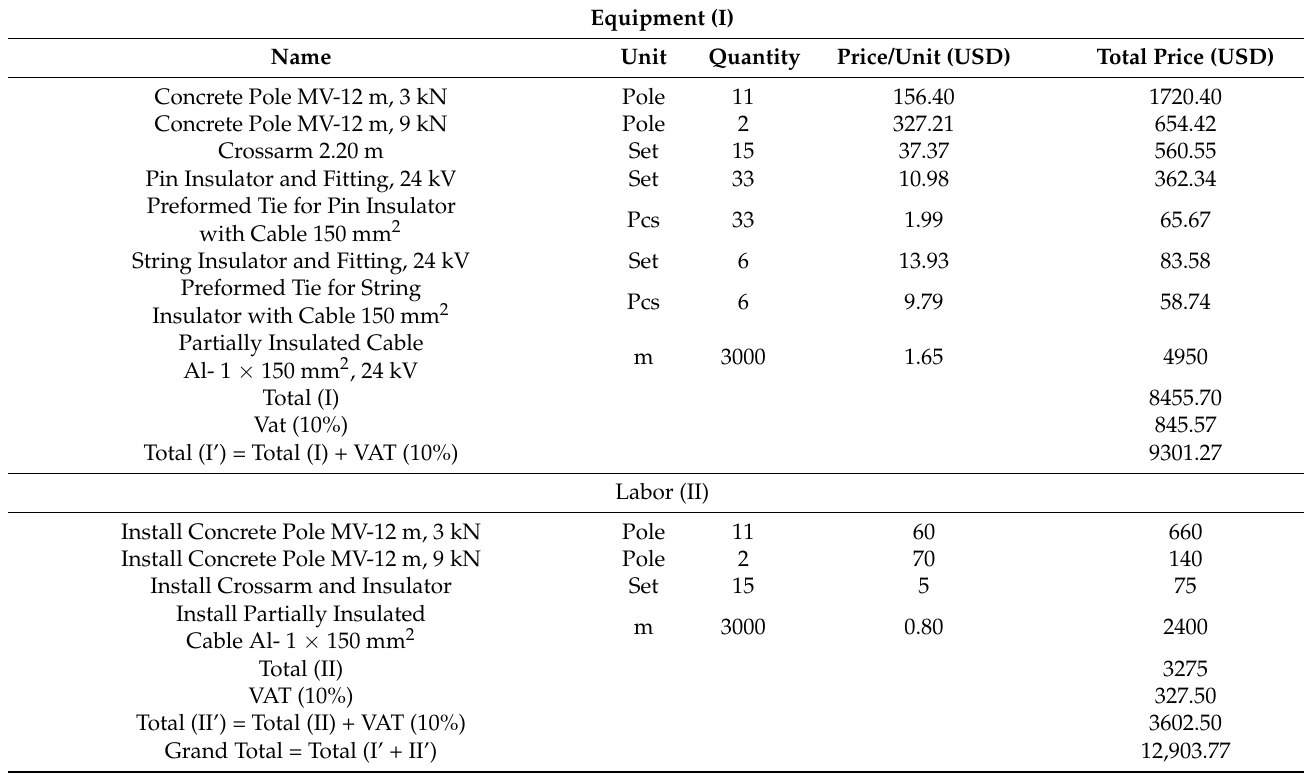
Table 4. The unit cost of medium voltage distribution in one